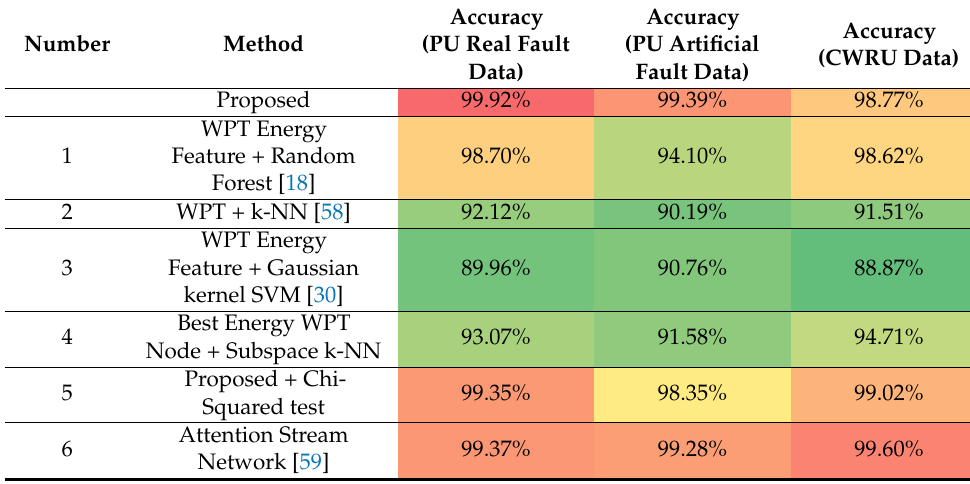
Table 7. Classification accuracy comparison with other methods. The classification accuracies from lowest to highest correspond to the color spectrum from green to